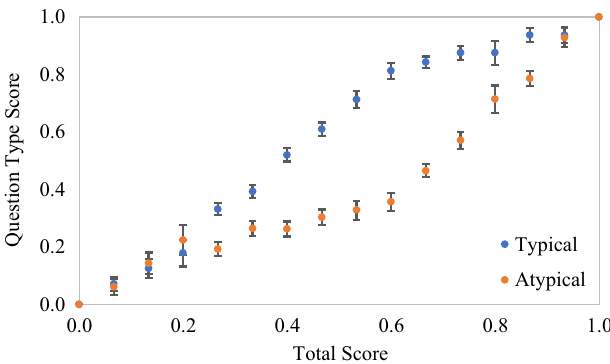
FIG. 4. Typical and atypical question scores based on total scores (with error bars denoting standard errors). The scores shown are the averages of all questions of that type (8 typical, 7 atypical, and 15 total questions). Differences are significant in the range of total scores of approximately 0.25 –